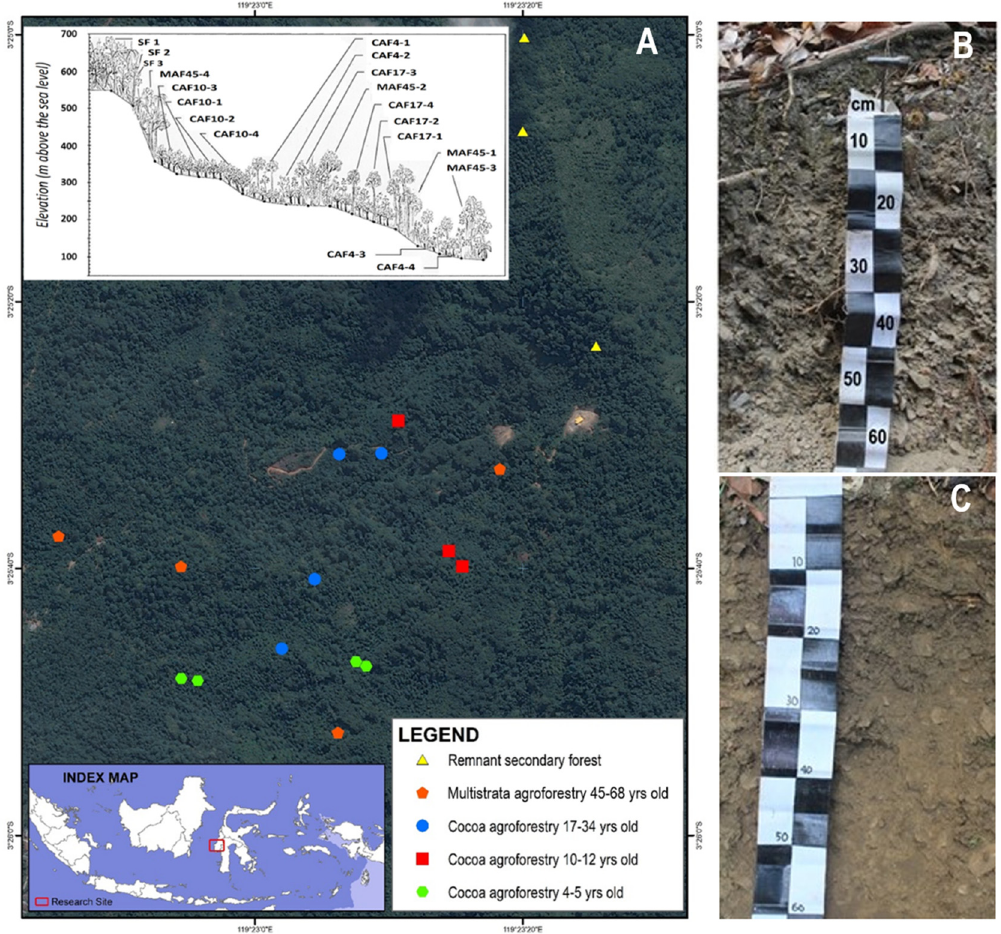
Figure 2. ( A ) The site distribution (satellite image) of remnant secondary forest (SF), multistrata agroforest that is 45–68 years old (MAF45), cocoa agroforestry that is 17–34 years old (CAF17), cocoa agroforestry that is 10–12 years old (CAF10), and cocoa agroforestry that is 4–5 years old (CAF4). The topo-sequence positions are shown to indicate slopes and elevations of the systems. The cocoa agroforestry sites are scattered randomly within 100 to 300 m above sea level (a.s.l.), generally 8 to 30% in slope, but the SFs are at > 400 m a.s.l. with a slope from 30 to over 40%. CAF (of all ages) refers to cocoa farming practices where at least five other tree species (with shade and / or direct use functions) are used alongside cocoa trees as the main crop. MAF denotes a farming practice of multiple tree species, dominated by horticultural trees, cocoa is not the main crop. ( B ) A typical (common) soil profile of the study area for all land uses showing abundance of rock fragments, especially below a 20 or 30 cm depth. ( C ) A profile of less stony soil (uncommon).